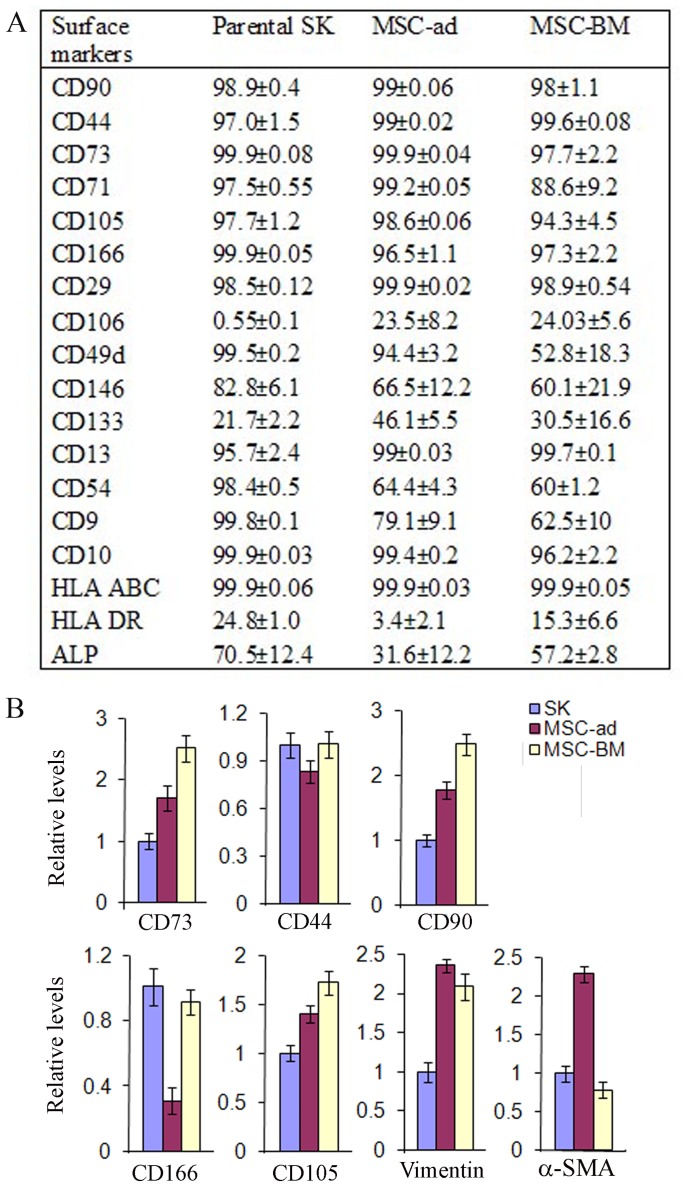
Characterization and comparison of SK cells with mesenchymal stem cells.A, flow cytometry was employed to detect classical mesenchymal stem cell (MSC) markers in three cell types, SK Hep-1 cells (SK cells), adipose-derived MSC (MSC-ad), and bone marrow-derived MSC (MSC-BM). B, expression of MSC markers, vimentin (a mesodermal origin marker), and alpha smooth muscle actin (α-SMA) was measured by quantitative PCR in three cell types. Abbreviations: HLA ABC, major histocompatibility complex (MHC) class I antigen; HLA DR, MHC class II antigen; ALP, Alkaline phosphatase.